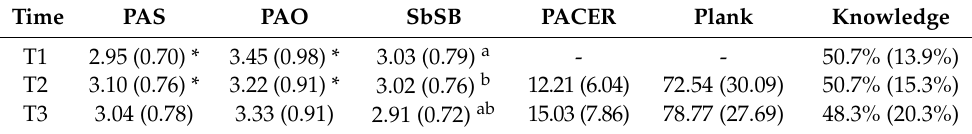
Table 2. Descriptive results for the behaviors, fitness, and knowledge by time—M (SD).